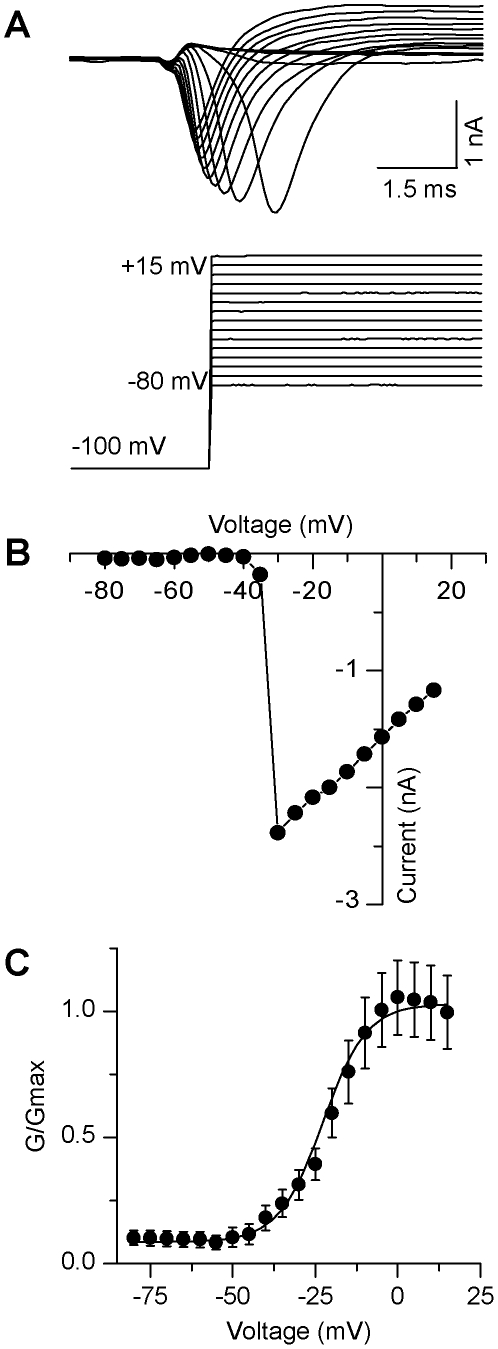
Voltage-gated sodium currents from individual GFP+ TK23 cells.
A, Representative example of fast-activating, fast-inactivating inward current (upper panel) evoked by depolarizing current steps (lower panel; steps range from −80 mV to +15 mV; pre-pulse to −120 mV; Vm = −60 mV). B, Peak current-voltage plot for the cell shown in A. C, Average (±sem) activation curve for all neurons (n = 36).